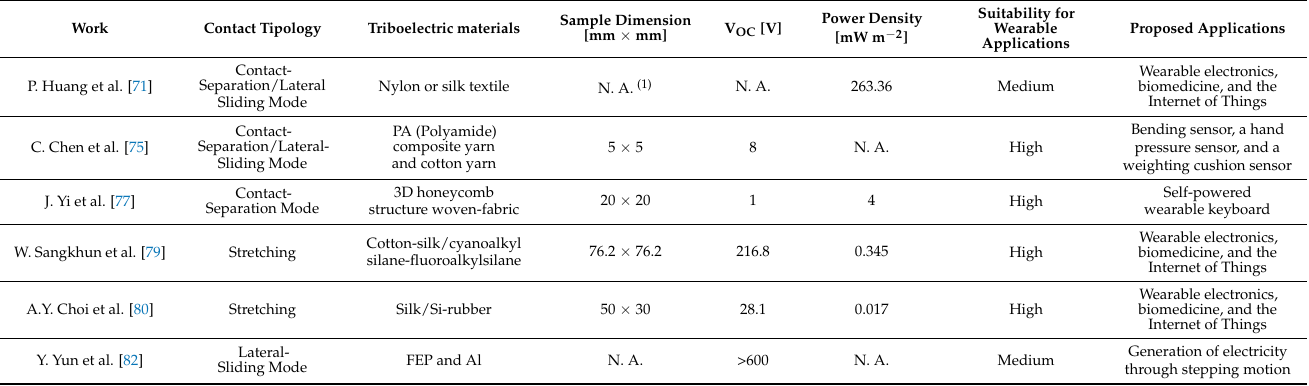
Table 4. Comparative table of triboelectric generators for wearable